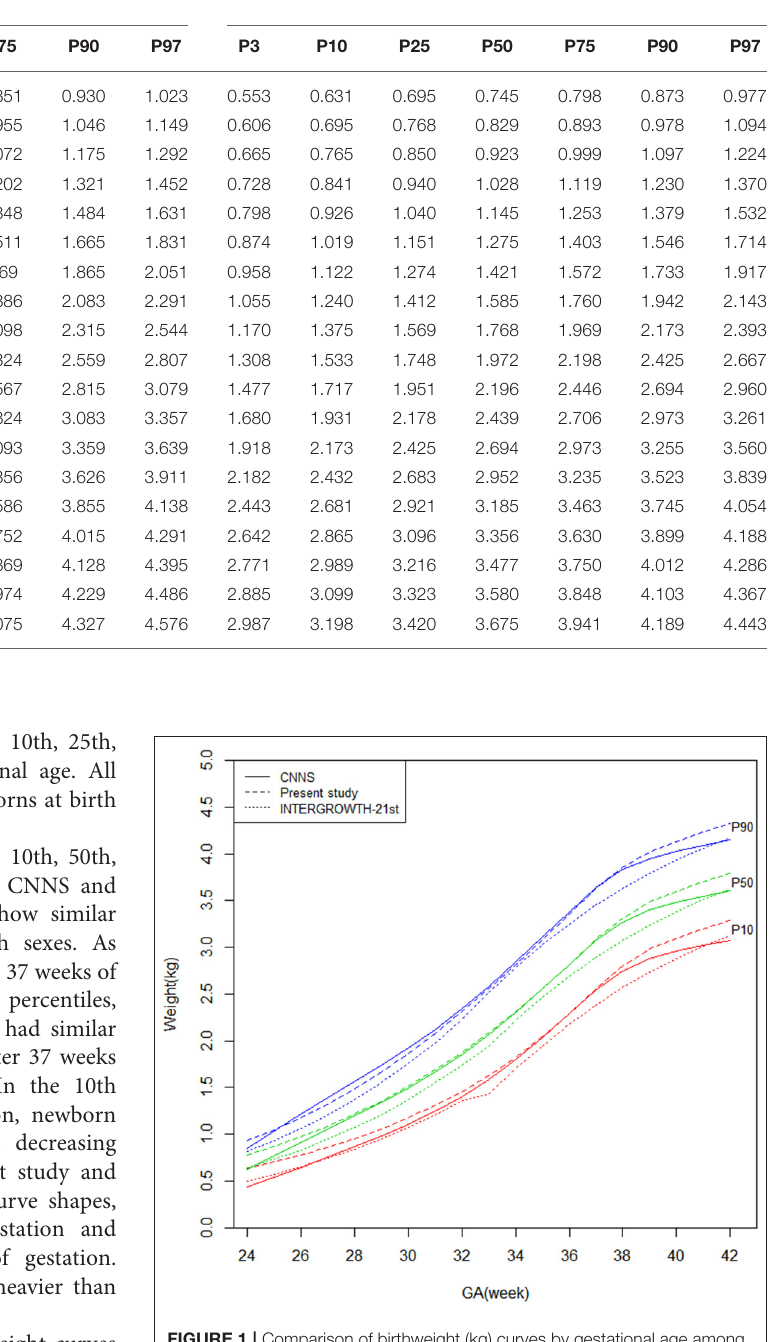
TABLE 1 | Birthweight (kg) percentiles by gestational age. Gestational age, weeks